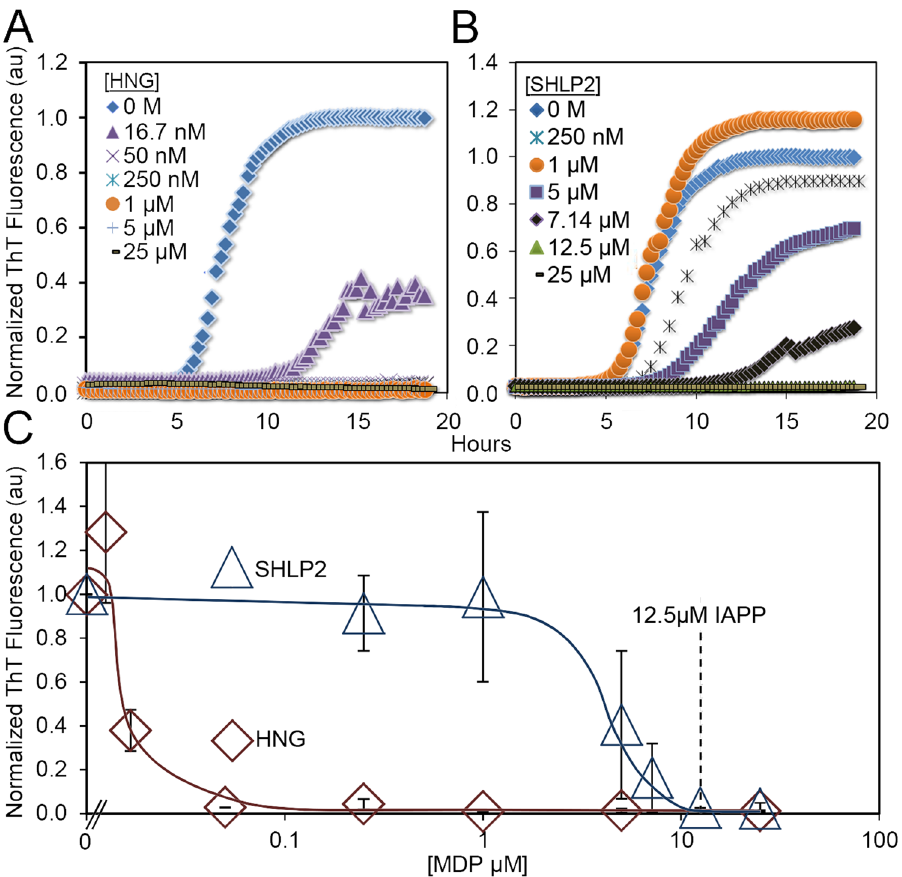
Figure 1. Mitochondrial-derived peptides HNG and SHLP2 inhibit IAPP fibrilization. ( A and B ) Representative ThT kinetics traces of IAPP misfolding in the presence of a) HNG or b) SHLP2. ( C ) End point analysis of IAPP misfolding by ThT fluorescence at 18 hours. Trend lines are shown for clarity. Concentrations of MDPs used to inhibit IAPP misfolding are given in micromolar below the figure. * p < 0.01 . Error bars represent + / − 1 standard deviation from a minimum of 3